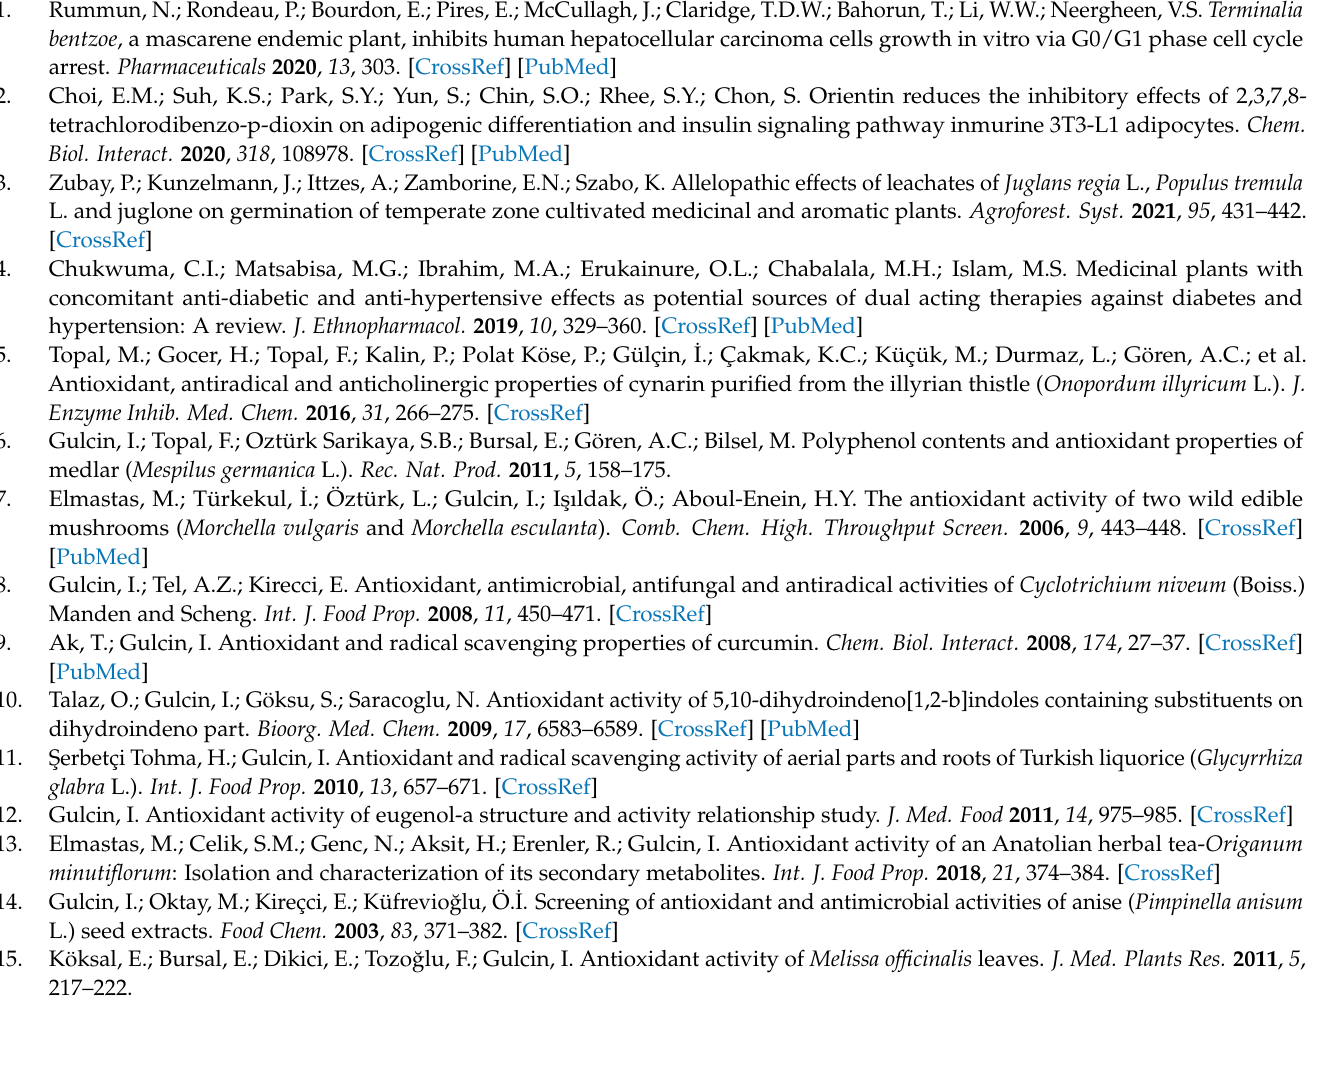
Supplementary Materials: The following are available online. Figure S1: TIC chromatogram of EESF Figure S3: TIC chromatogram of WESF in negative ionization mode, Figure S4: TIC chromatogram of WESF in pozitive ionization